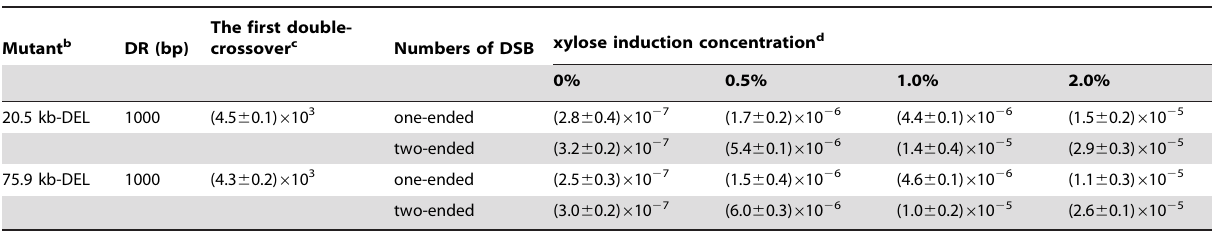
Table 3. Effect of the number of I-S ce I sites on the counter-selection for large-scale deletion a .